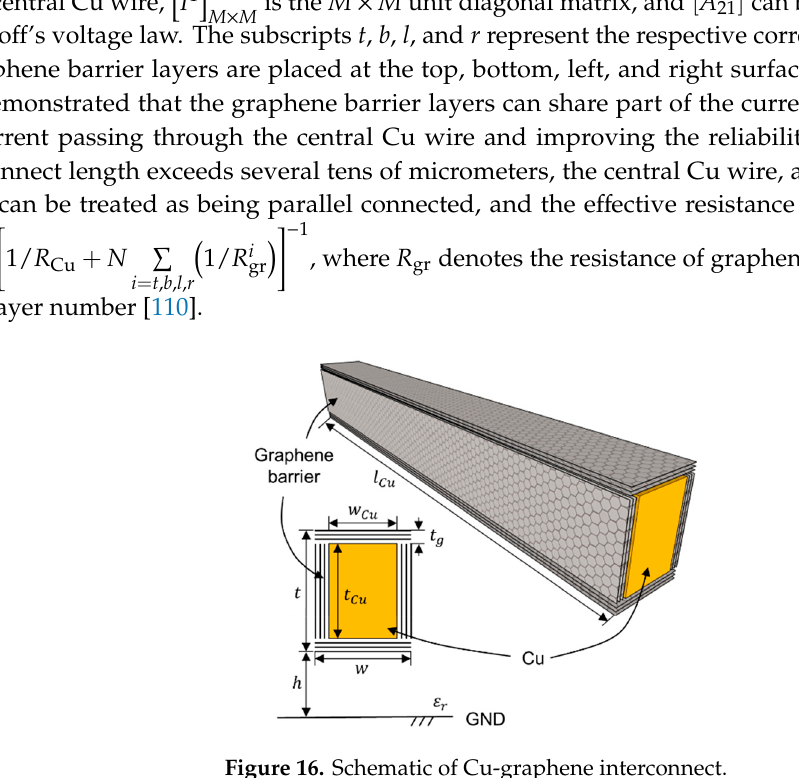
Figure 16. Schematic of Cu-graphene interconnect.